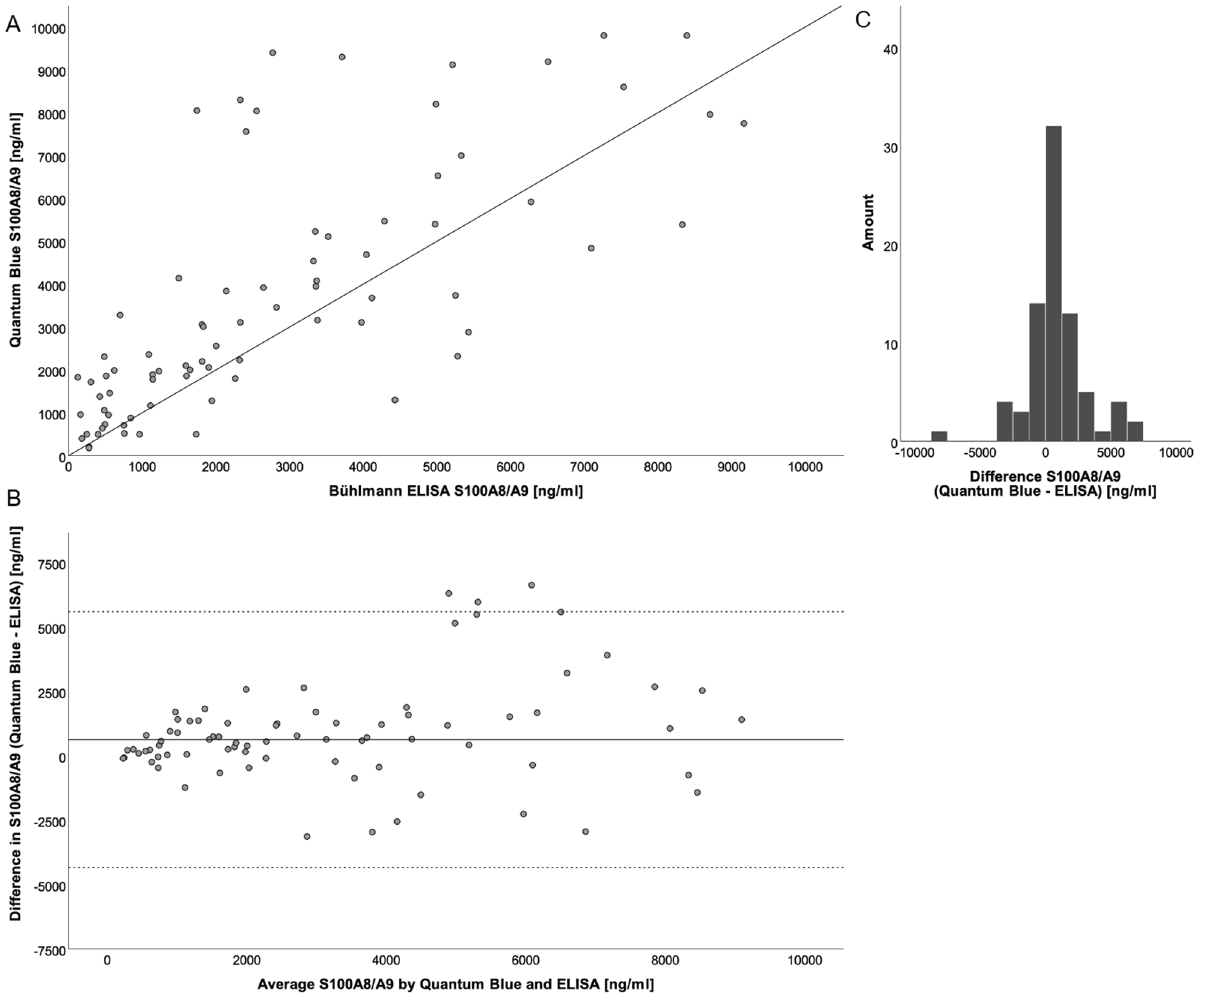
Figure 2. Agreement between QUANTUM BLUE and ELISA. Scatter plot of S100A8/A9 concentration in saliva determined by ELISA and QUANTUM BLUE rapid test with line of equality (f(x) = 1 × x + 0) to illustrate the degree of agreement ( A ). The Bland–Altman plot of difference between S100A8/A9 levels determined by QUANTUM BLUE and ELISA against mean S100A8/A9 levels shows a positive bias for the QBT (solid line, mean; dashed line, 2 × standard deviation; ( B )). The differences follow a normal distribution, which is illustrated by a histogram ( C